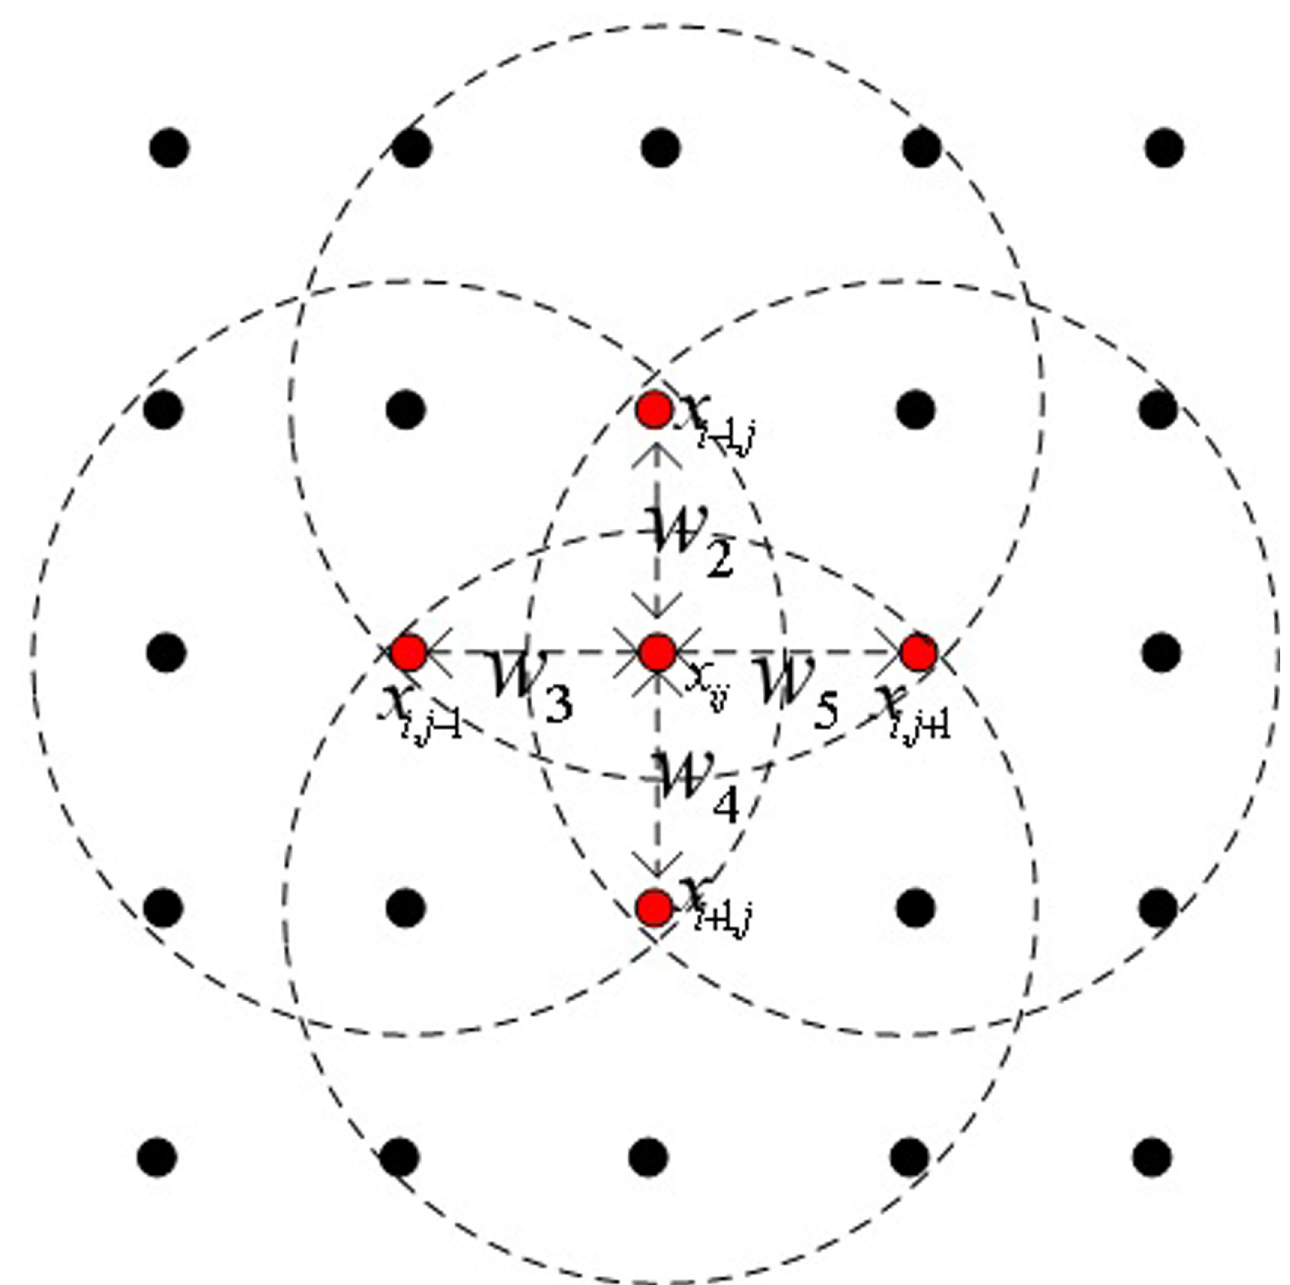
Fig 2. Four nearest neighbors of a pixel x ij and their weights between x ij